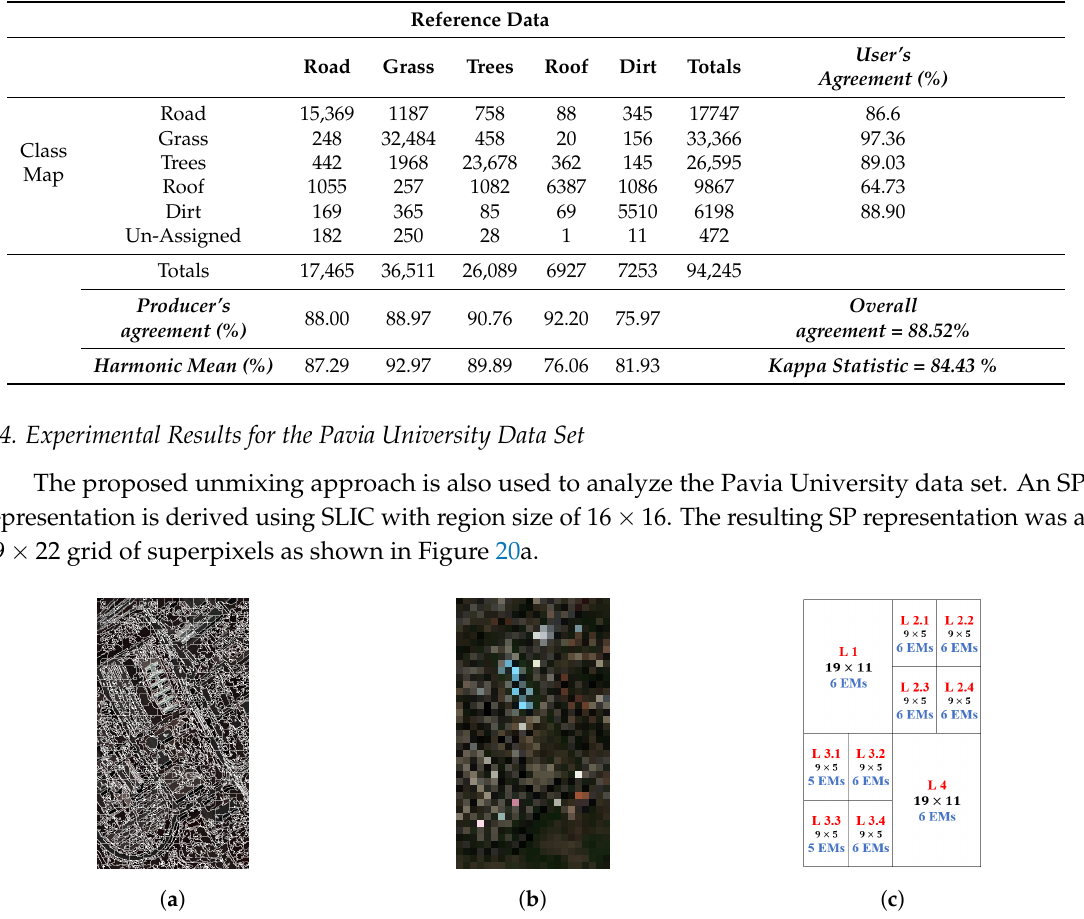
Figure 20. SLIC superpixel representation of ROSIS Pavia image: ( a ) SLIC segmentation; ( b ) true-color display of the SP means image; ( c ) Pavia SP means image partitioning using quadtree (EMs = Endmembers per